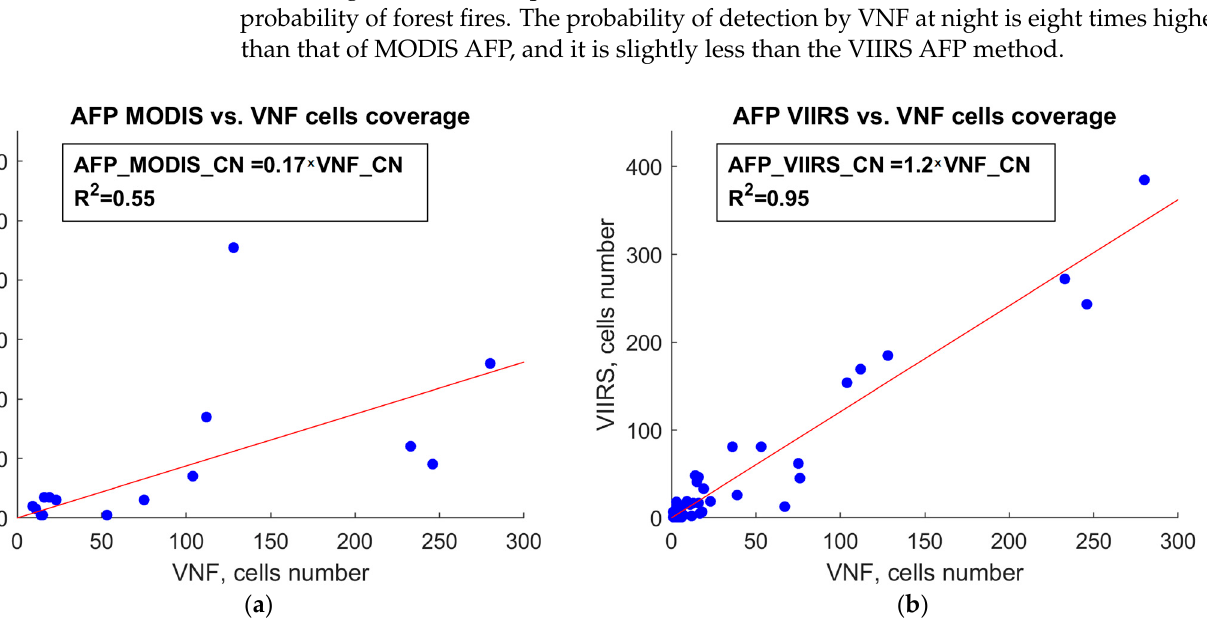
( b ) Figure 17. Comparison of VNF and AFP by radiative power from forest fires: ( a ) VNF vs. MODIS AFP; ( b ) VNF vs. VIIRS AFP. 6. Conclusions The mid-wave infrared (3–5 um) has been referred to as a crossover zone [20], in which the radiance observed from space contains both a reflected sunlight component and thermal emissions from objects within pixels, such as clouds, water bodies and land sur- faces. This is shown in Figure 18, where it can be seen that the VIIRS MWIR bands fall on